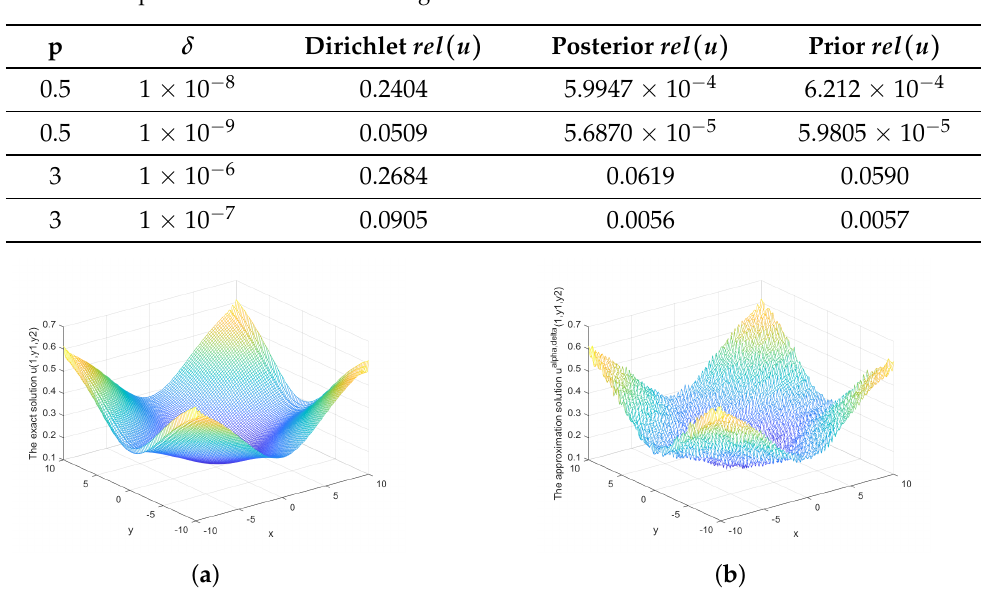
Table 2. Comparison between different regular solutions at x = 1.